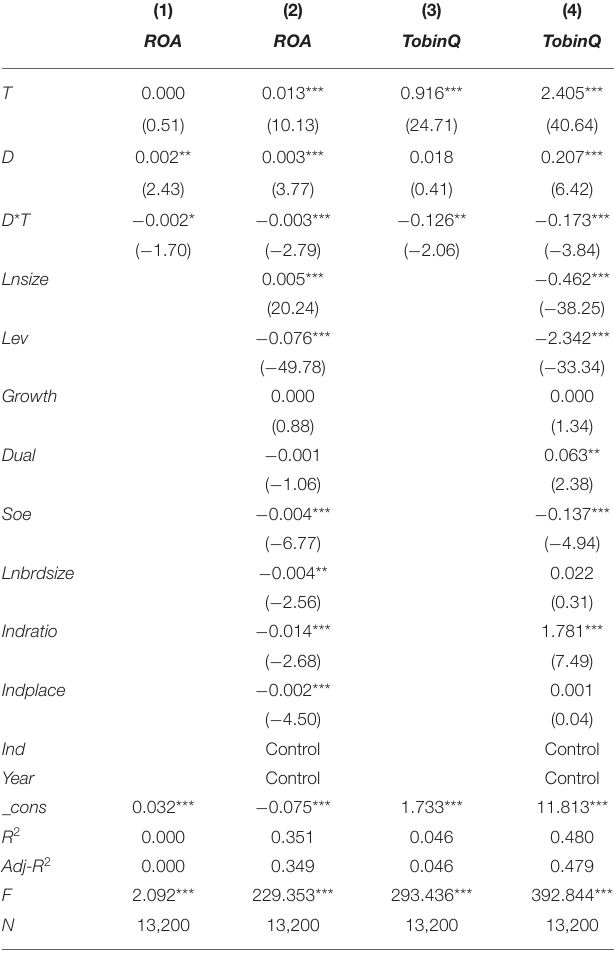
TABLE 6 | Regression analysis for GID resignation and firm